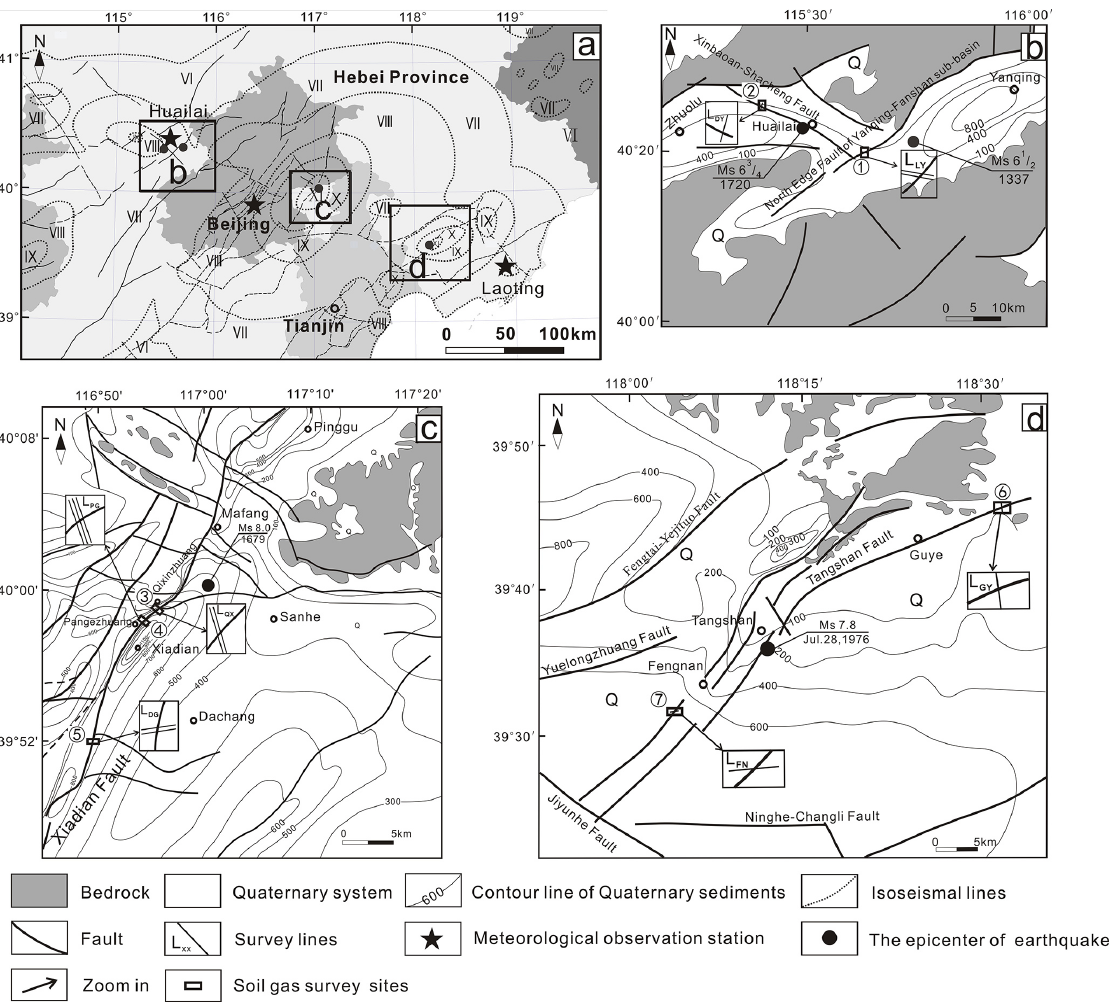
Figure 1. Simplified geological maps of study areas in the capital area of China (modified after Zhu et al., 2006; Seismic Geological Brigade, CEA, 1979; Yin, 2010; Guo et al., 2011). (a) shows the locations of study areas and meteorological observation stations. (b–d) show the geologic structure and locations of soil gas profiles in Yanqing–Huailai Basin, the Sanhe–Pinggu region and the Tangshan region, respectively. 1 (cid:13) represents the LY profile, 2 (cid:13) the DY profile, 3 (cid:13) the QX profile, 4 (cid:13) the PG profile, 5 (cid:13) the DG profile, 6 (cid:13) the GY profile, and 7 (cid:13) the FN profile (full names of profiles provided in the